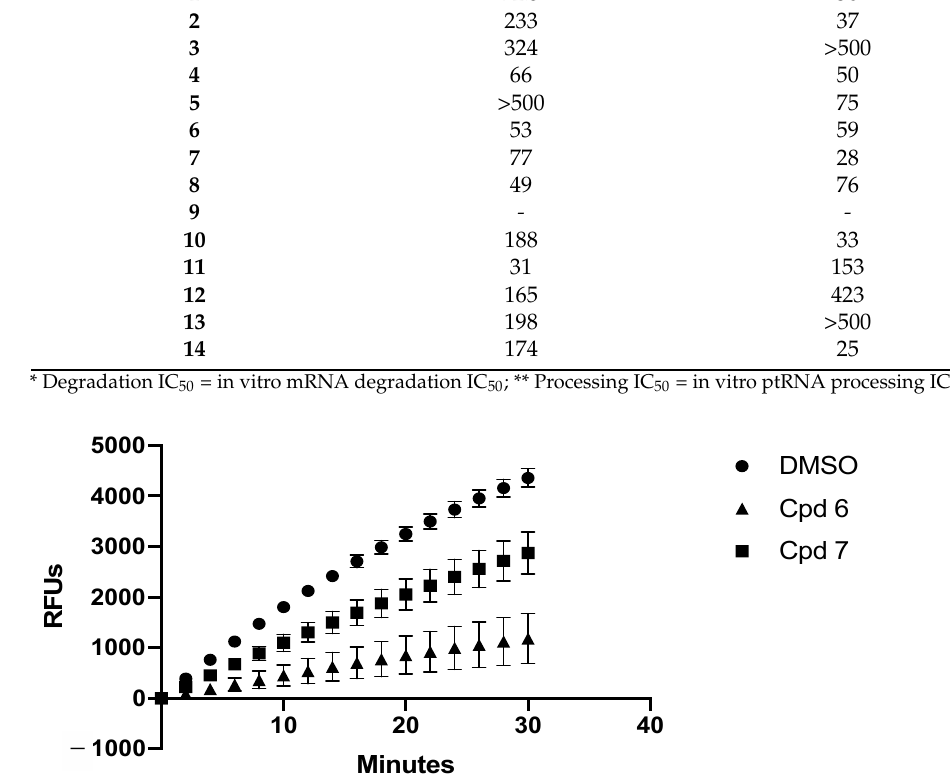
Table 2. IC 50 values of compounds 1 – 14 .